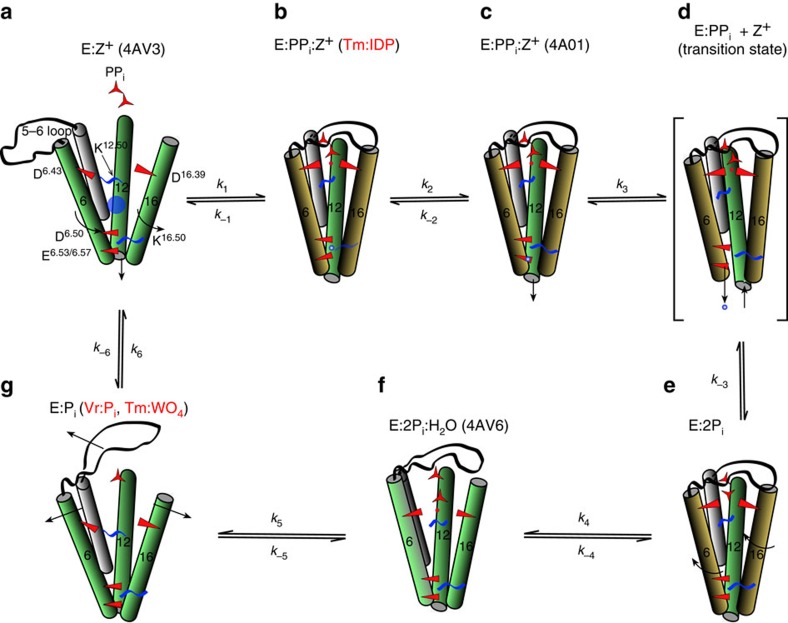
Complete kinetic scheme of M-PPase catalytic cycle.(a–g) All the proposed conformational states of the M-PPase catalytic cycle are shown in order, including the transition state for pumping (d) and a ‘relaxed product' state (f) analogous to yeast pyrophosphatase46. The structures used in the manuscript are shown, with the new structures marked in red; for the rest, the PDB code is shown. For clarity, only key helices involved in formation of the hydrolytic centre and ion channel are displayed. Aspartate and lysine residues are shown in red and blue respectively and labelled on state (a). Changes to helix position and rotation are denoted with arrows and by changes in the shading of the helices. The pumped ion (Na+/H+) is represented as a blue sphere in states (b–d) and as a large blue sphere in state (a) to denote the unknown position of the pumped ion in the channel of the resting state. The nucleophilic water is represented as a red sphere in states (b–d).